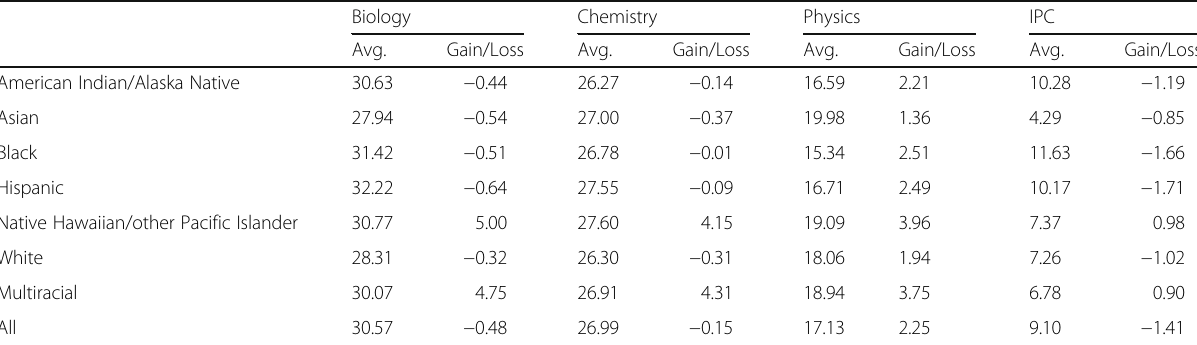
Table 11 Six-year average enrollment rates and gain/loss of enrollment by race/ethnicity in required and selective science